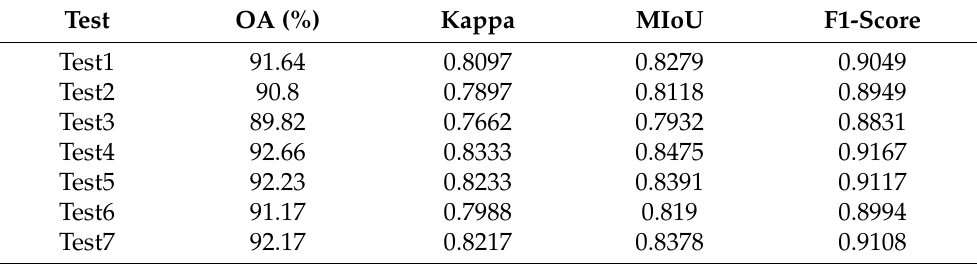
Table 8. Impervious surface extraction accuracies of Deeplabv3+ with different feature inputs.